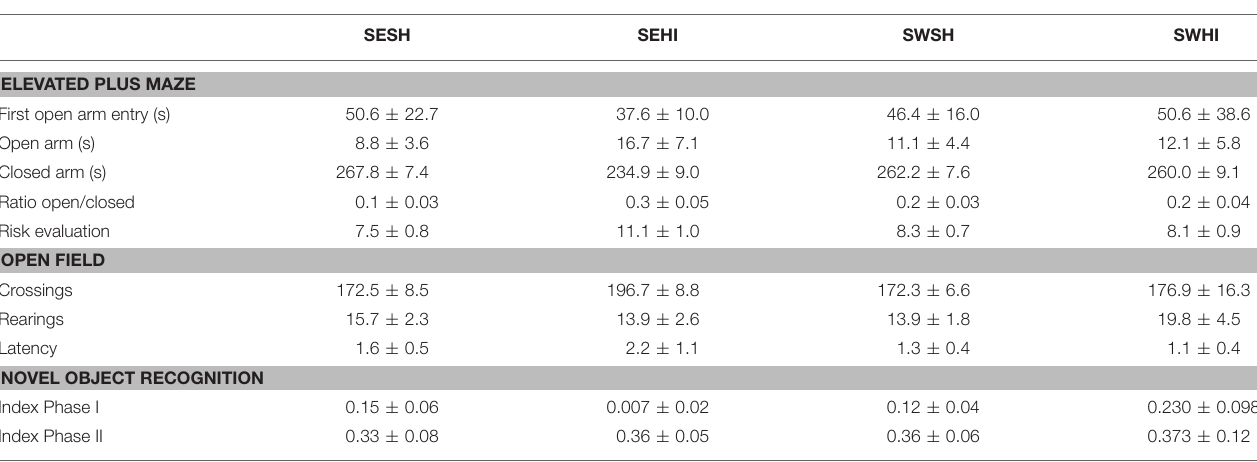
TABLE 3 | Behavioral analysis at adult age. SESH SEHI SWSH